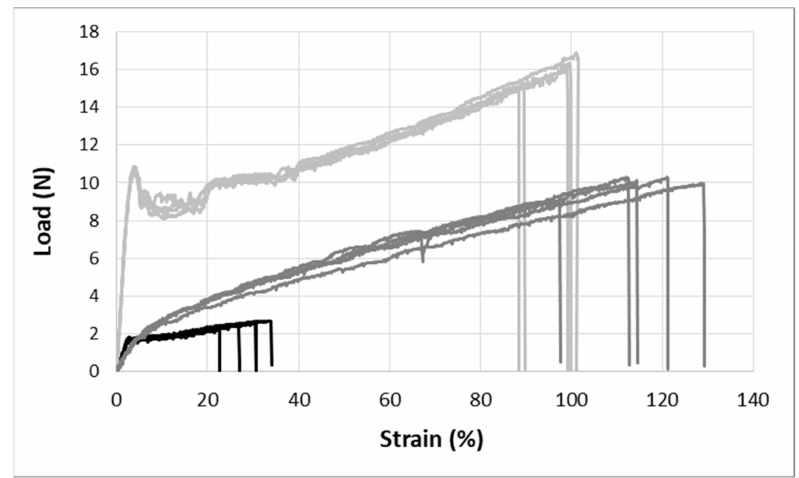
Figure 4. Load-strain curve for the three studied optical fibers: Empa bi-component (black), Empa Geniomer ® (dark grey) and GigaPOF 50-SR (soft grey).